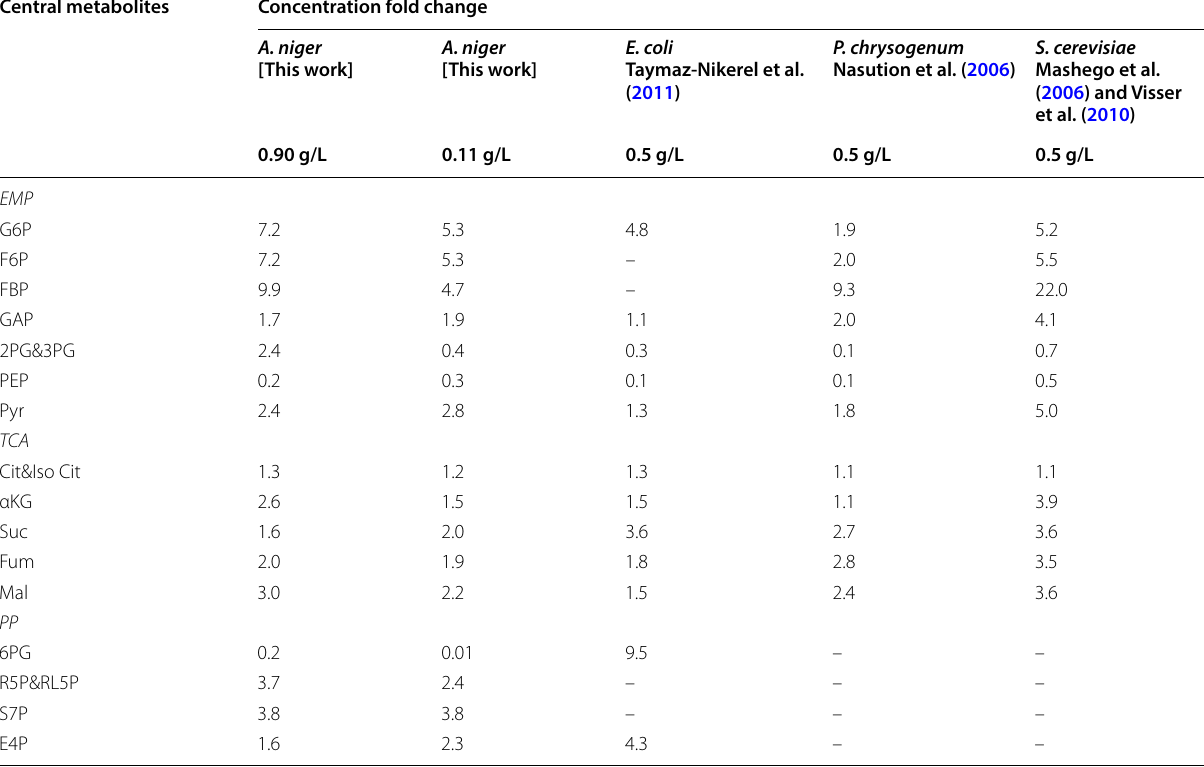
Metabolites in the state of glucose excess use maximum or minimum concentration fold change